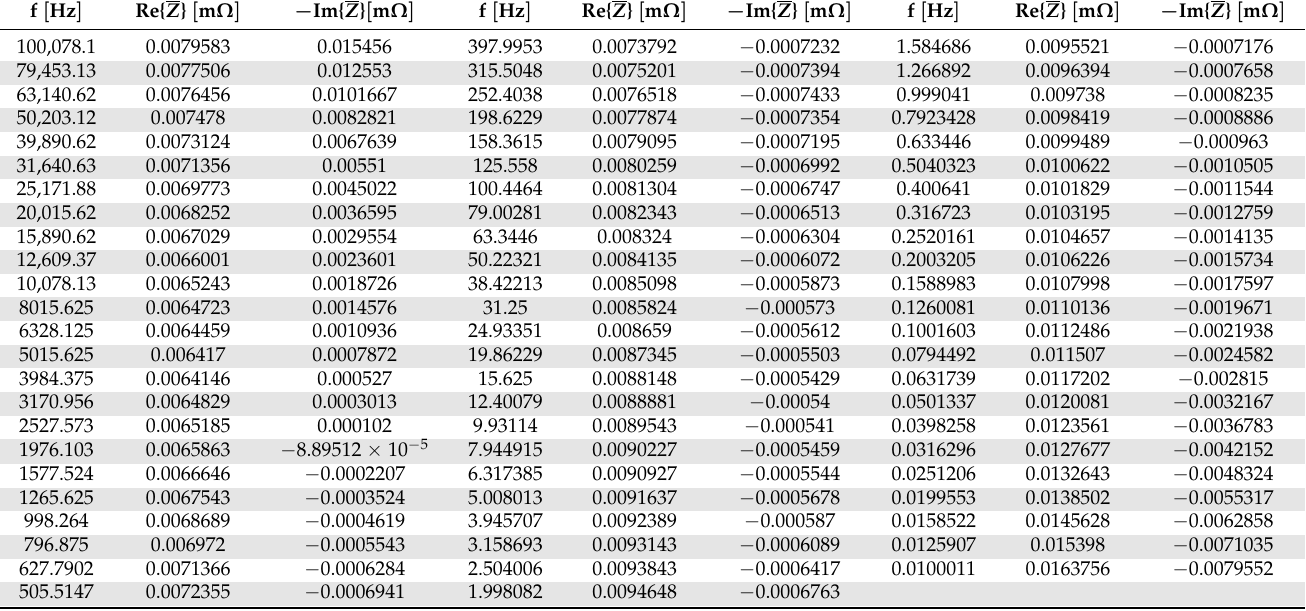
Table A5. EIS data for Lithiumwerks M1B at an SOC of